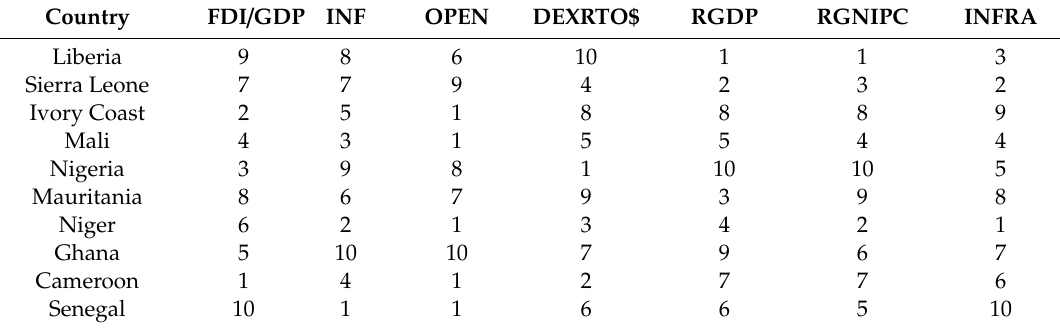
Table 2. Rankings of the mean for the various economies by variable (ascending order). Source: Authors’ work.